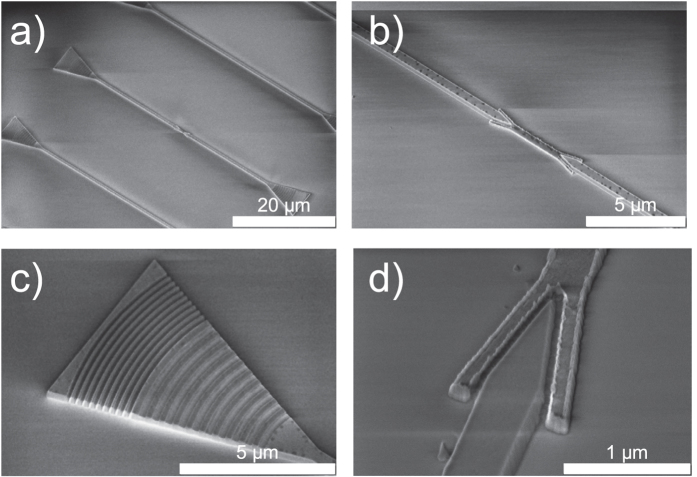
Scanning electron micrographs of the fabricated structures (a–c) before Ni removal). (a) Overview of the entire structure showing the dielectric grating couplers and the dielectric waveguides with a short plasmonic waveguide in its middle. The dielectric waveguides not containing a plasmonic waveguide above and below are used as references. (b) Zoom-in showing the plasmonic waveguide and the dielectric-plasmonic transducers. (c) The photonic grating-coupler, consisting of a partially etched grating and a Bragg-reflector. (d) Zoom-in to the photon-to-plasmon transducer with a 40 nm gap between metallic and dielectric components.